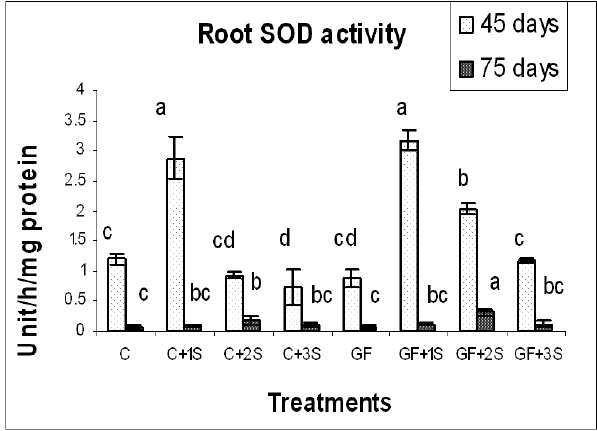
Fig. 3. SOD activity from roots of Allium sativum L. after 45 and 75 days of AM